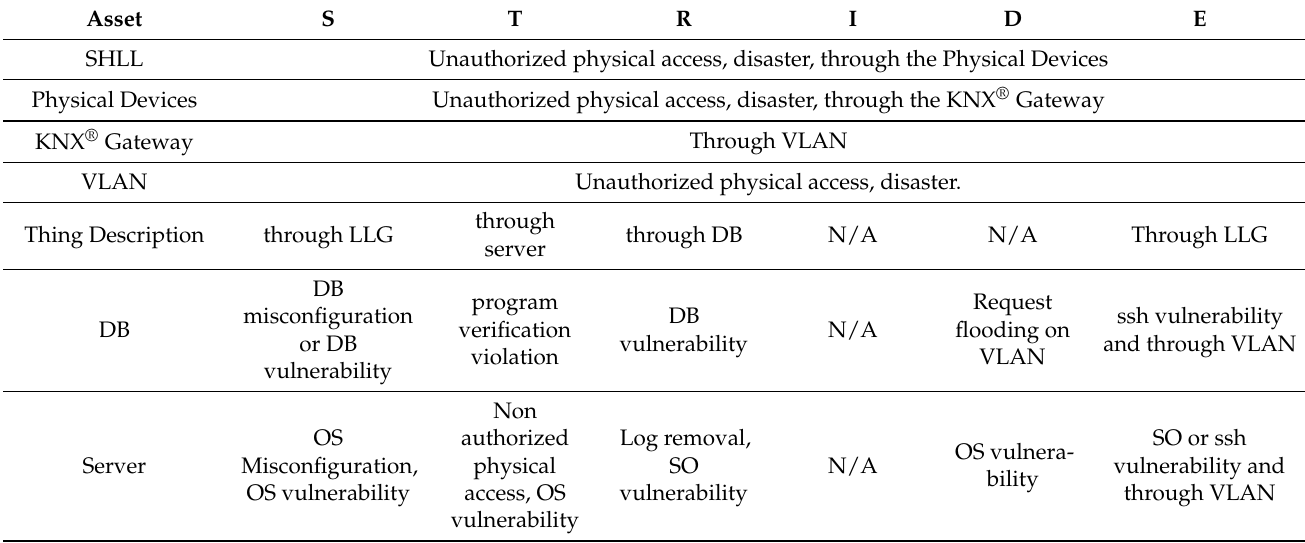
Table 1. STRIDE analysis on the assets to be protected, in order to find the potential